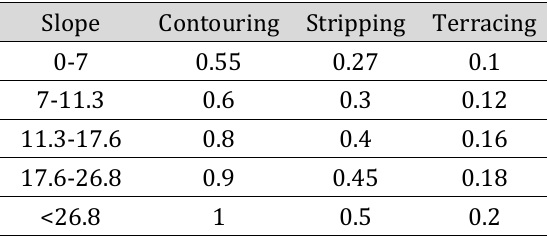
Table 1. Support practice (P) factor values based on slope gradients of croplands [26]